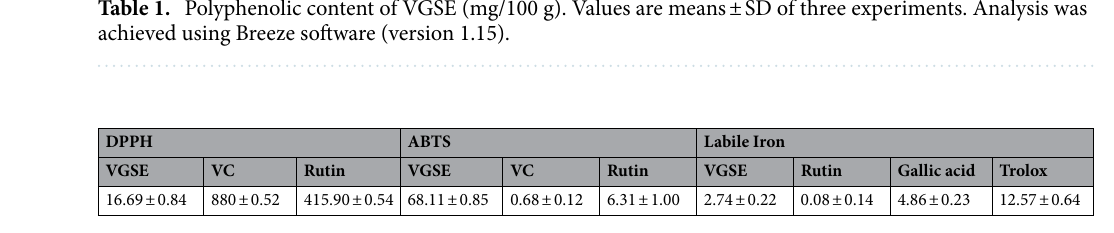
Table 2. In vitro free radical inhibition activity. IC 50 (µg/mL) is the concentration of VGSE or antioxidant compounds that can scavenge free radicals by 50%. Values are means ± SD of three experiments. Analysis was achieved using GraphPad Prism software (version